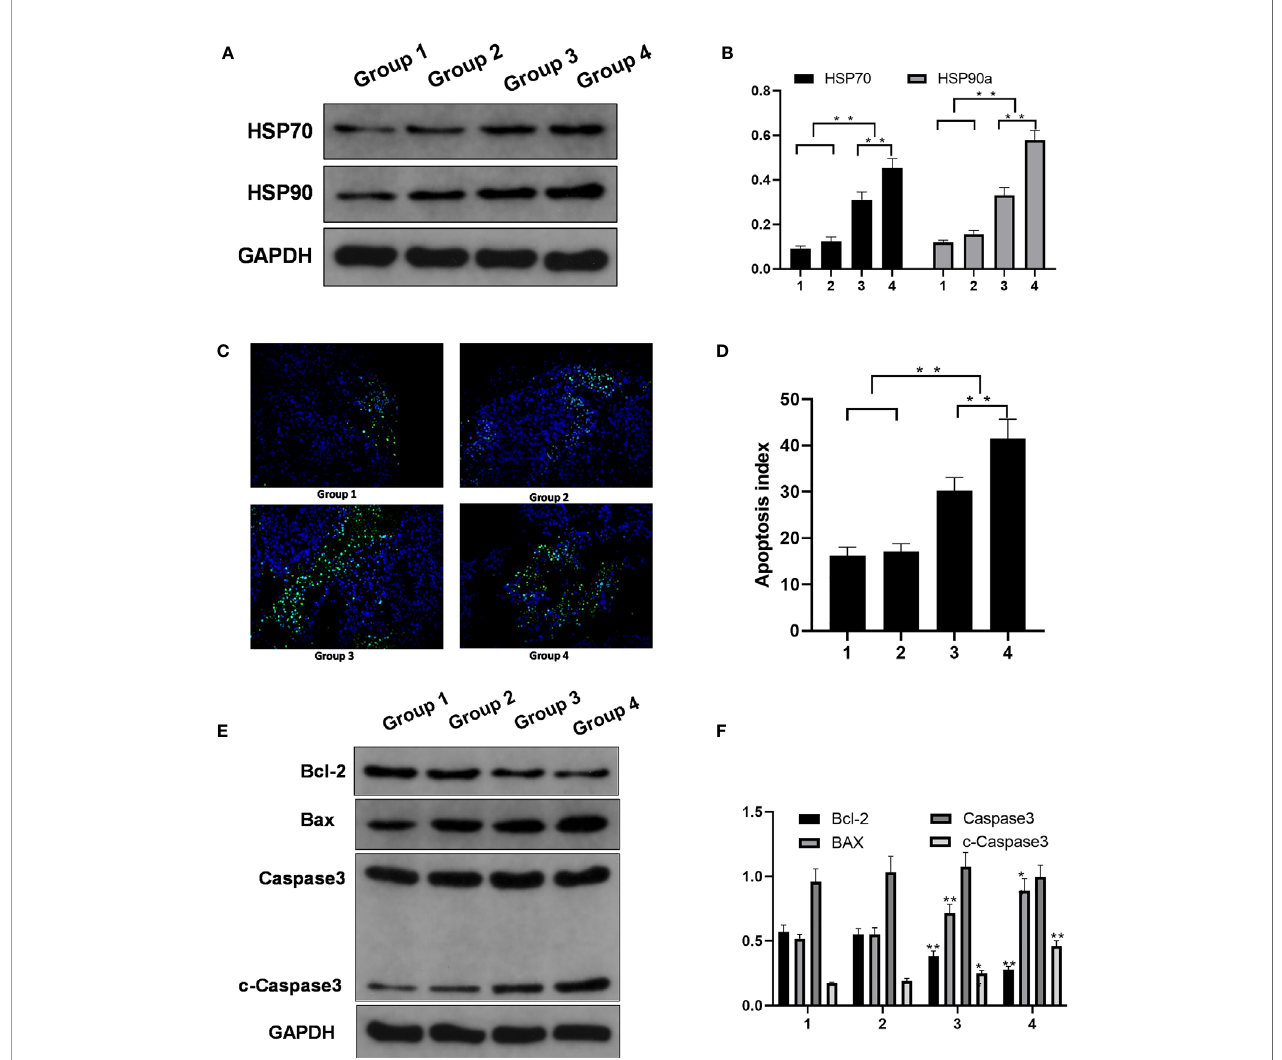
FIGURE 4 | Molecular changes in the control groups and the experimental groups. (A) HSP70 and HSP90a expression. (B) HSP70 and HSP90a expression levels in four groups. Signi fi cant differences were calculated in groups 1 and 2 vs . groups 3 and 4, groups 3 vs . 4. (C) TUNEL expression (magni fi cation). (D) Apoptosis index of the four groups. Signi fi cant differences were calculated in groups 1 and 2 vs . groups 3 and 4, groups 3 vs . 4. (E) Protein expression. (F) Bcl-2, BAX, and c-capase3 protein expression level in four groups. Signi fi cant differences were calculated between groups 1 and 2 vs . groups 3 and 4. *p < 0.05, **p <